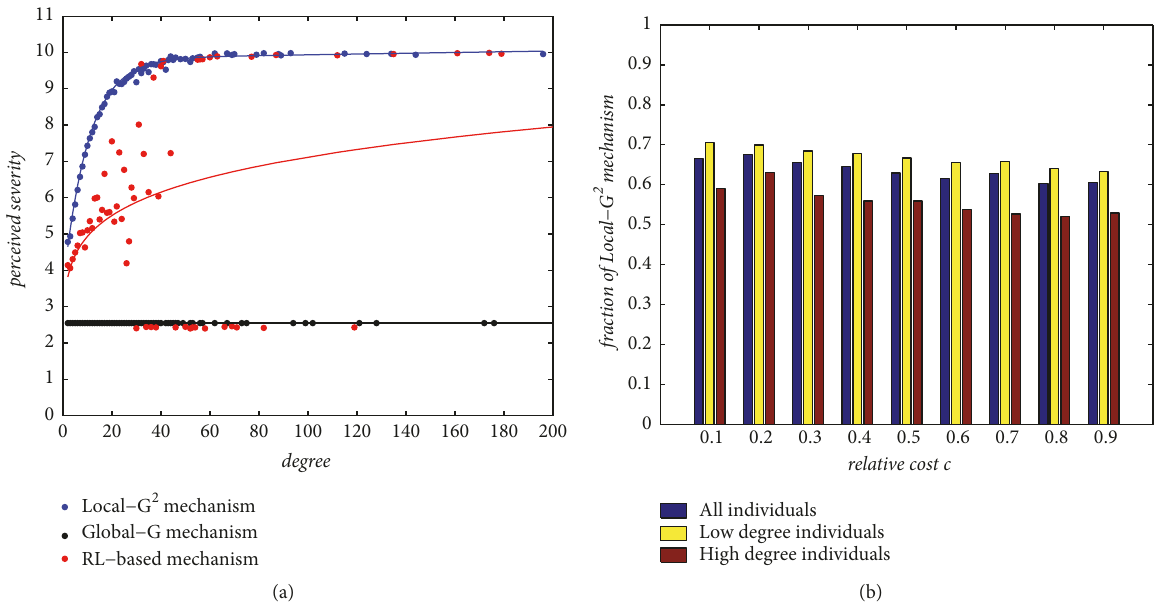
Figure 6: The individual performance of the RL-based decision-making mechanism. (a) The perceived epidemic severity for individuals with different social connections under different decision-making mechanisms when the relative cost 𝑐 = 0.5 . (b) The fraction of individuals who adopt the local- 𝐺 2 mechanism in different groups. Simulations are carried out on a scale-free network with network size 𝑁 = 10 , 000 and average degree ⟨𝑘⟩ = 4 . The results are averaged over the last 500 epidemic